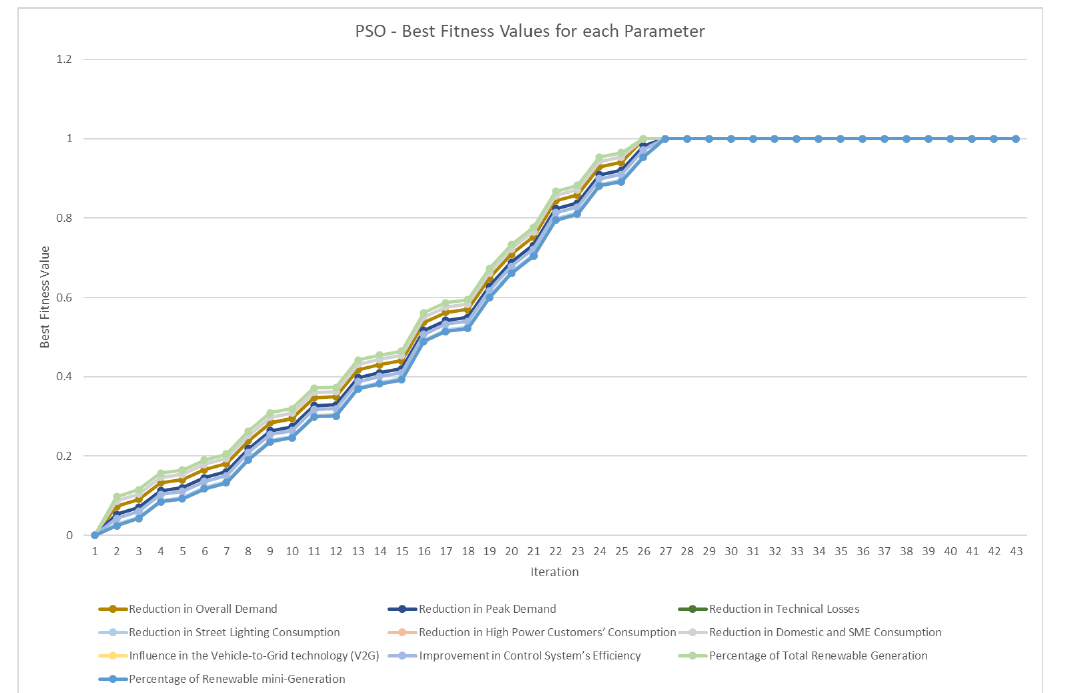
Figure 10. Best fitness values per generation for 10 parameters in GAEC.